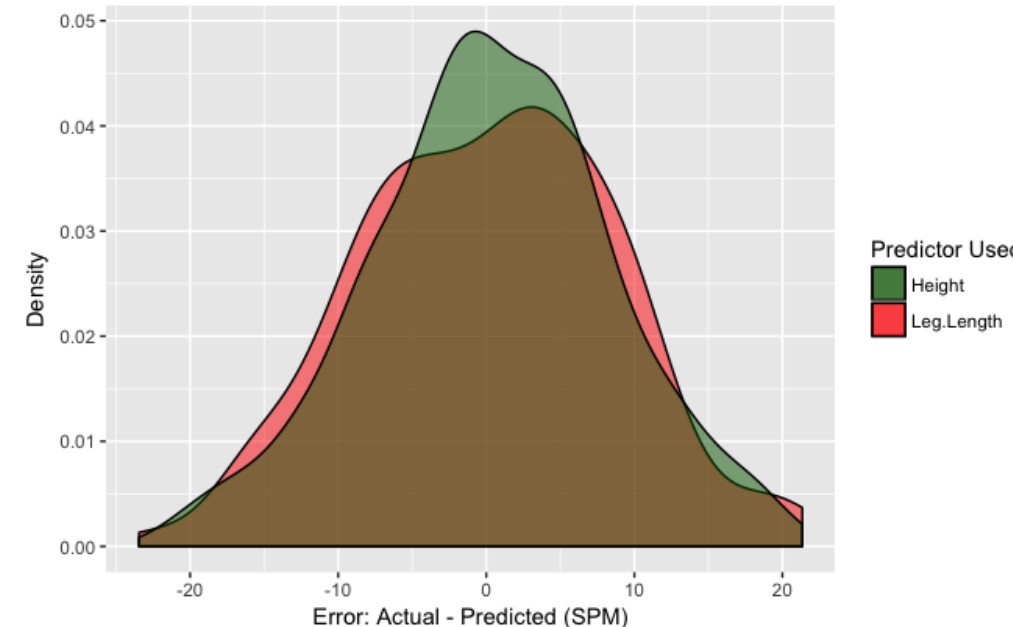
Figure 1. Density distribution of within-sample prediction error (spm) for both height (green shade) and leg length (red shade) models. Int. J. Environ. Res. Public Health 2018 , 15 , x FOR PEER REVIEW